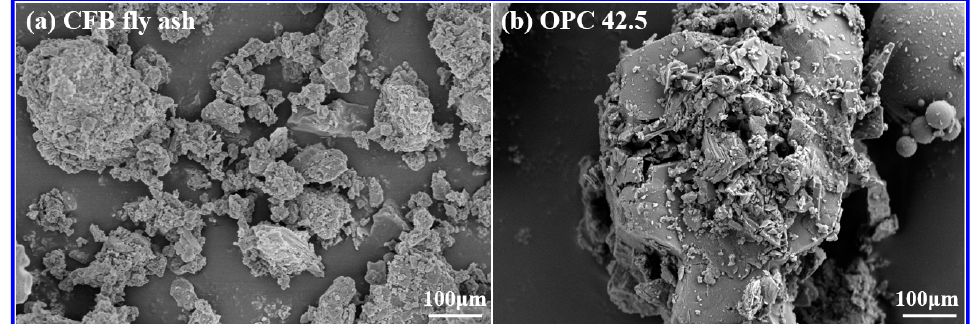
4 of 21 Figure 2. Particle size distribution of CFB fly ash and OPC.